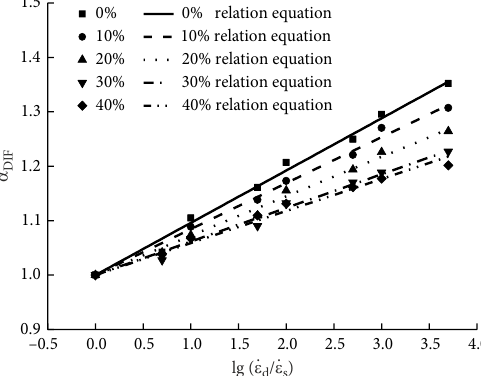
Figure 9. Effect of strain rate on compressive strength Figure 10. Effect of strain rate on dynamic increase factor